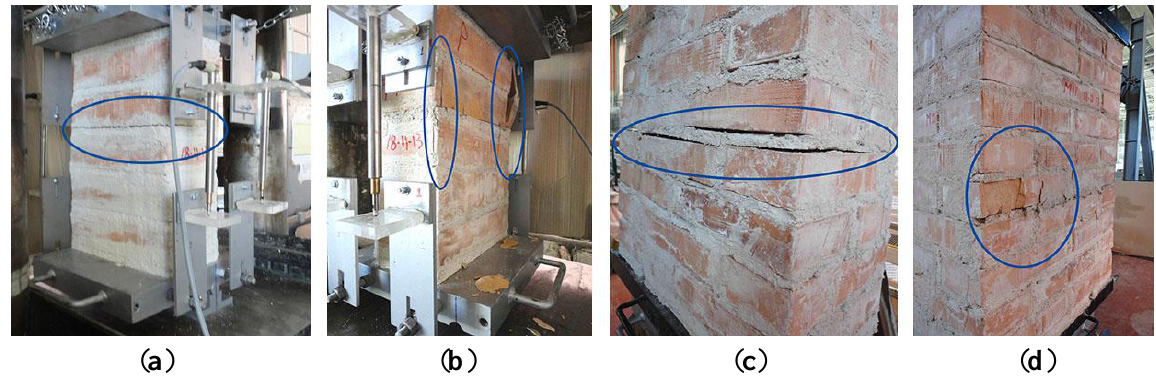
Figure 6. Failure mechanism of the URM specimens: ( a , b ) specimens “P”; ( c , d ) specimens